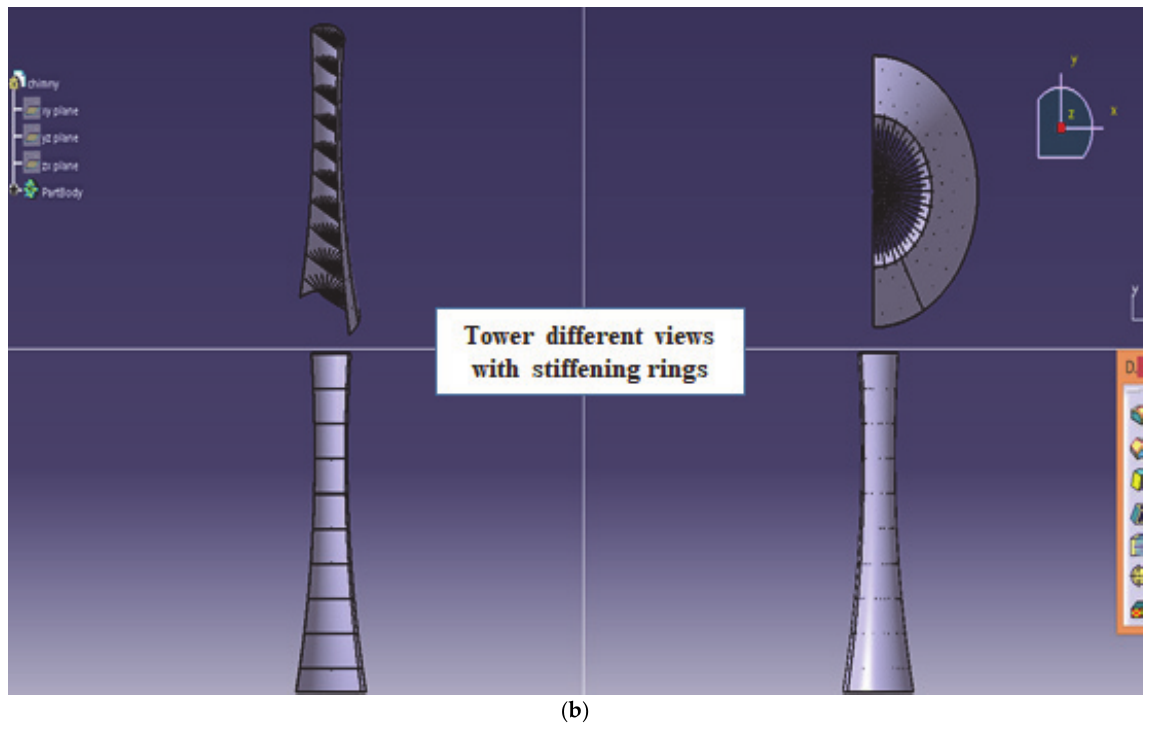
Figure 5. CAD view of SUTPP tower. ( a ) Tower base with guided cone and turbine casing configuration. ( b ) Section view of tower with stiffening rings.